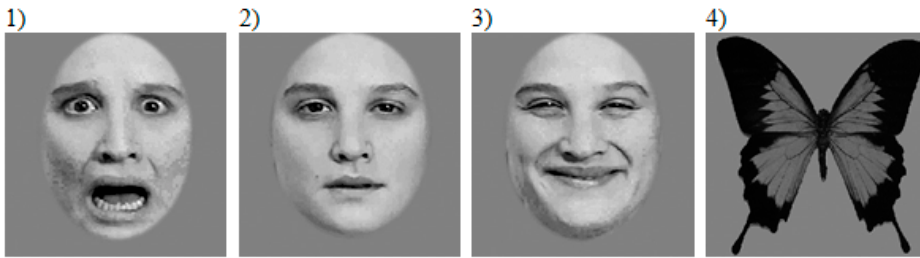
Figure 1. Examples of visual stimuli; ( 1 ) fearful facial expression, ( 2 ) neutral facial expression, ( 3 ) happy facial expression, ( 4 ) butterfly.